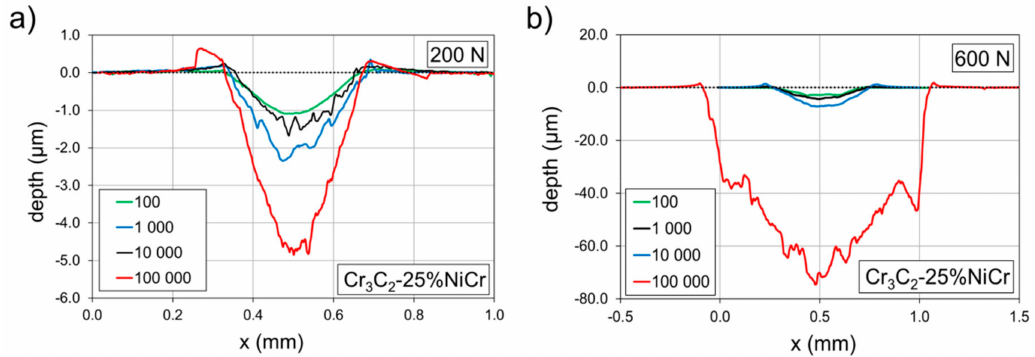
Figure 7. Profiles of the impact craters of the Cr 3 C 2 -25%NiCr coating. Comparison of the impact loads of ( a ) 200 N and ( b ) 600